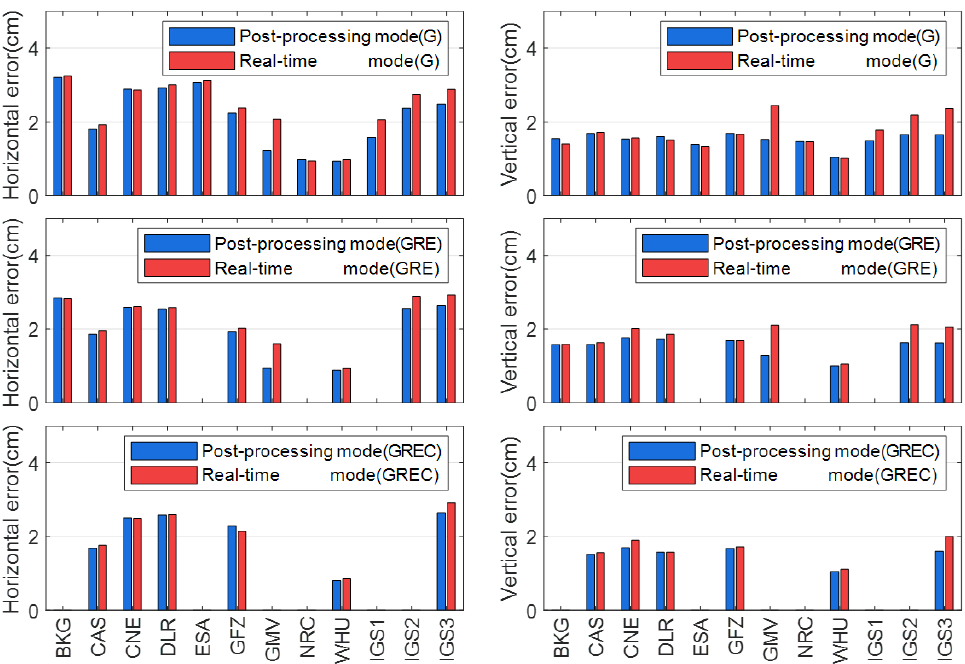
Figure 9. Static PPP errors using different SSR products for 16 IGS stations (24h).